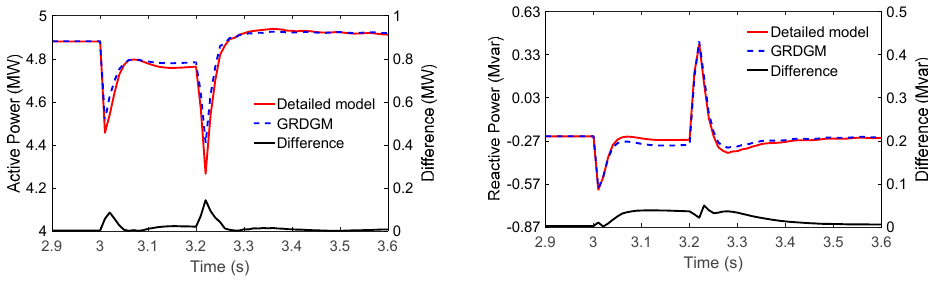
Figure 6. The renewable DGs’ responses under a 9.5% U n voltage dip.